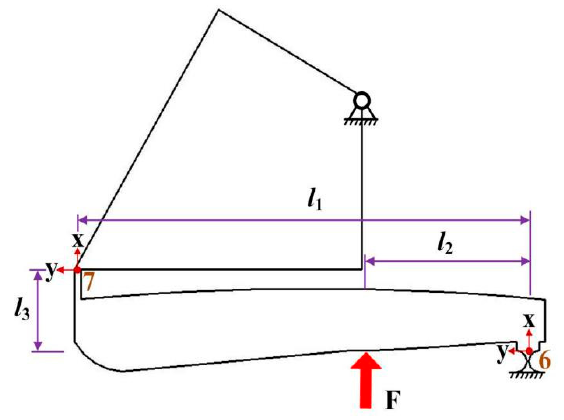
Figure 6. Schematic diagram of the lever mechanism.